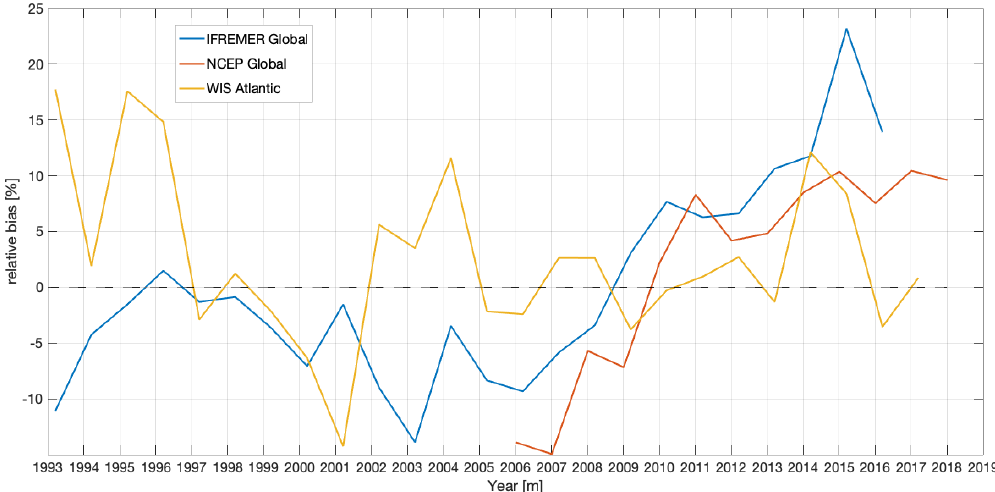
Figure 19. Relative bias binned by year. IFREMER is in blue, NCEP in red, and WIS in yellow. The dashed black line shows 0% bias